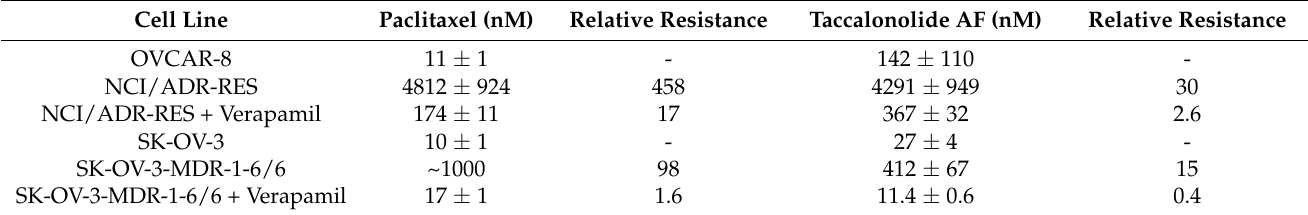
Table 2. TGI (nM) of paclitaxel and taccalonolide AF in MDR 1-expressing ovarian cancer cell lines as compared to isogenic parental lines or in the presence of the Pgp-inhibitor verapamil. Mean ± SEM n = 2–4. Relative resistance calculated as the TGI of the MDR1- expressing cell line divided by the TGI value in the isogenic parental